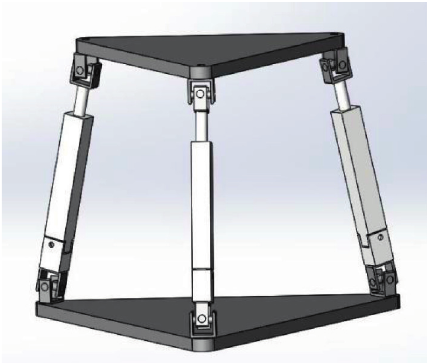
Figure 1: Model of the 3-UPU parallel vibration